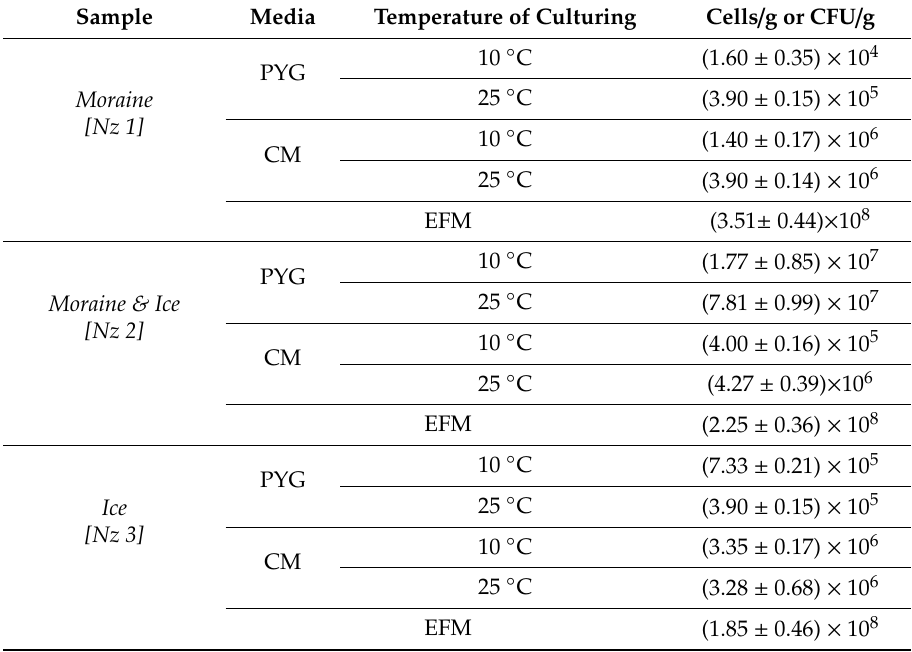
Figure A1. The samples collection points; ( a ) large-scale photo, ( b ) small-scale photo (images were obtained by Google Earth service). Table A1. Numbers of prokaryotic cells and numbers of culturable bacteria in the studied samples.